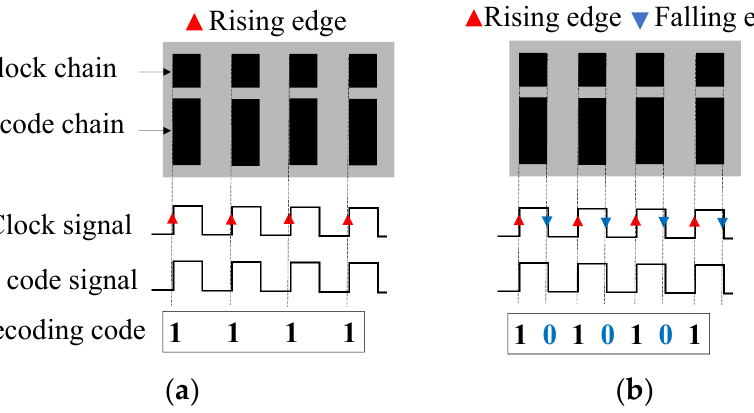
Figure 4. Scheme of the encoding system based on the rising ( a ) and rising/falling ( b ) edge of the clock signal. Reprinted with permission from [64].